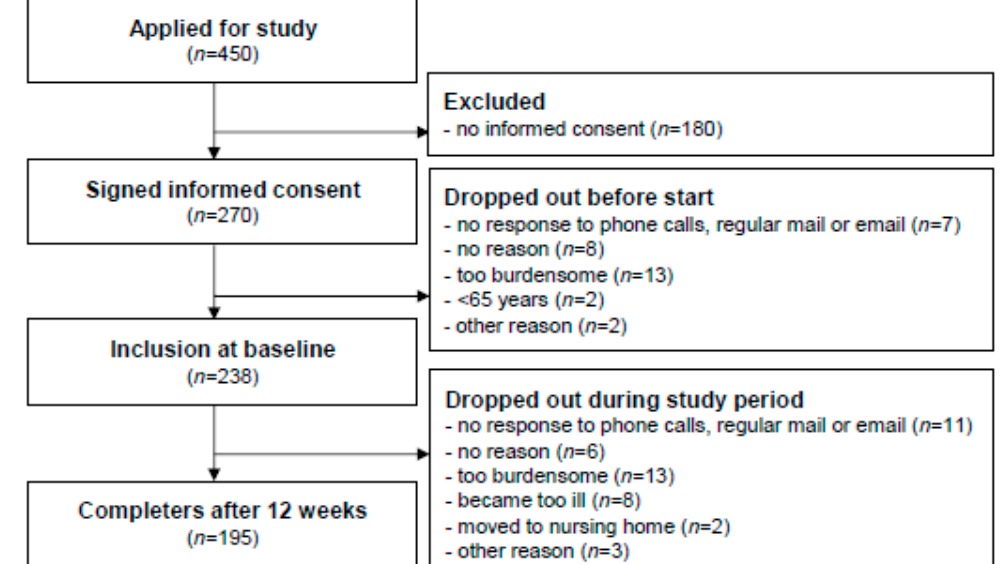
Figure 1. Flowchart of participants in the home-based exercise program.